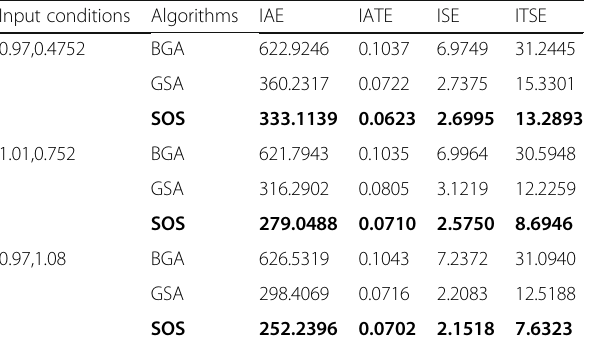
Table 3 Performance indices parameters for different applied